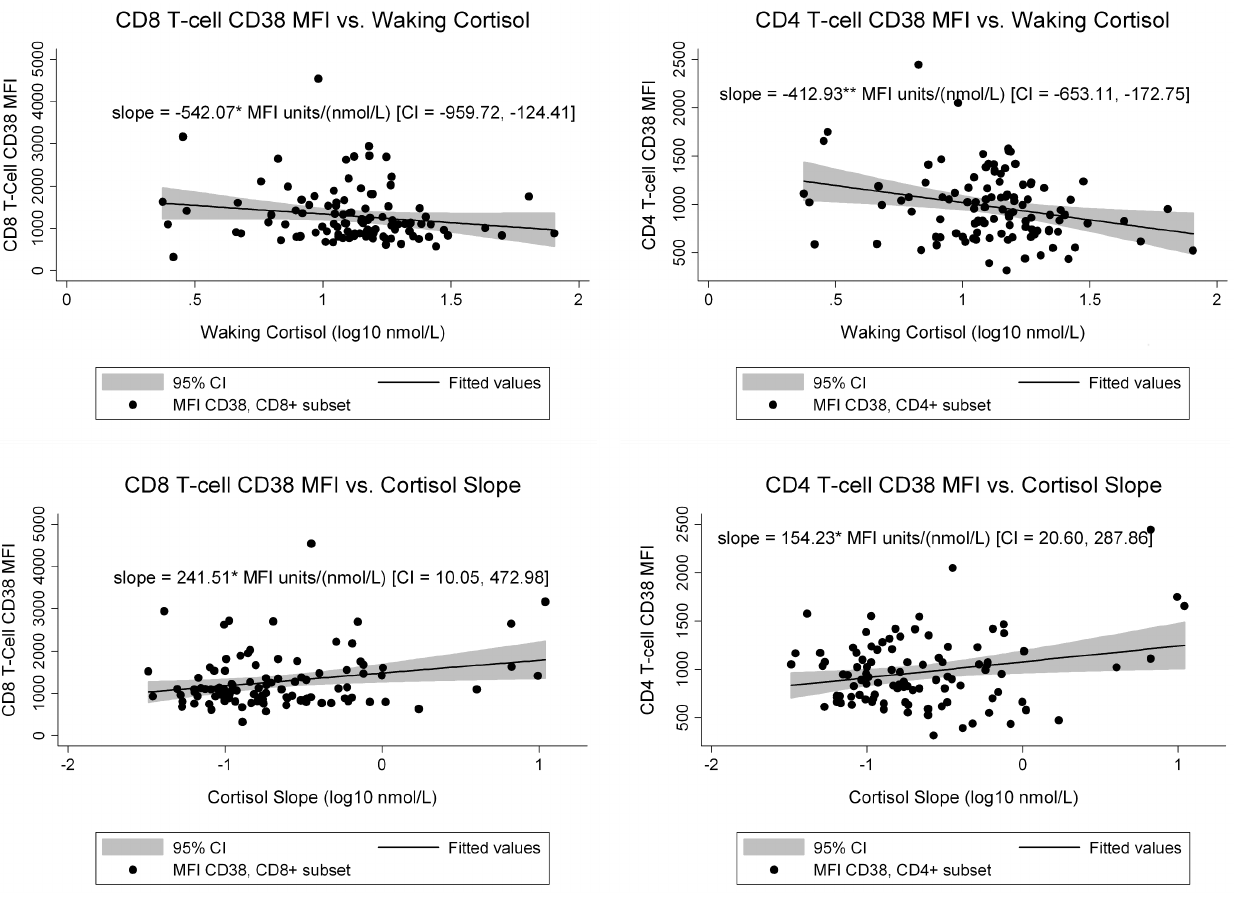
Figure 2. T cell activation as function of diurnal cortisol. The scatter plots show CD8 and CD4 activation as a function of waking cortisol or diurnal cortisol slope. The slope presented in the graphs is the multivariate regression coefficient for T-cell activation as a function of cortisol measures, adjusted for age, viral load, and CD4 count. Figure 2A shows CD38 mean fluorescent intensity (MFI) on CD8 + T cell in relationship to waking cortisol. Figure 2B shows CD38 mean fluorescent intensity (MFI) on CD4 + T cell in relationship to waking cortisol. Figure 2C shows CD38 mean fluorescent intensity (MFI) on CD8 + T cell in relationship to diurnal cortisol slope. Figure 2D shows CD38 mean fluorescent intensity (MFI) on CD4 + T cell in relationship to diurnal cortisol slope. *=p , .05. **=p # .001.